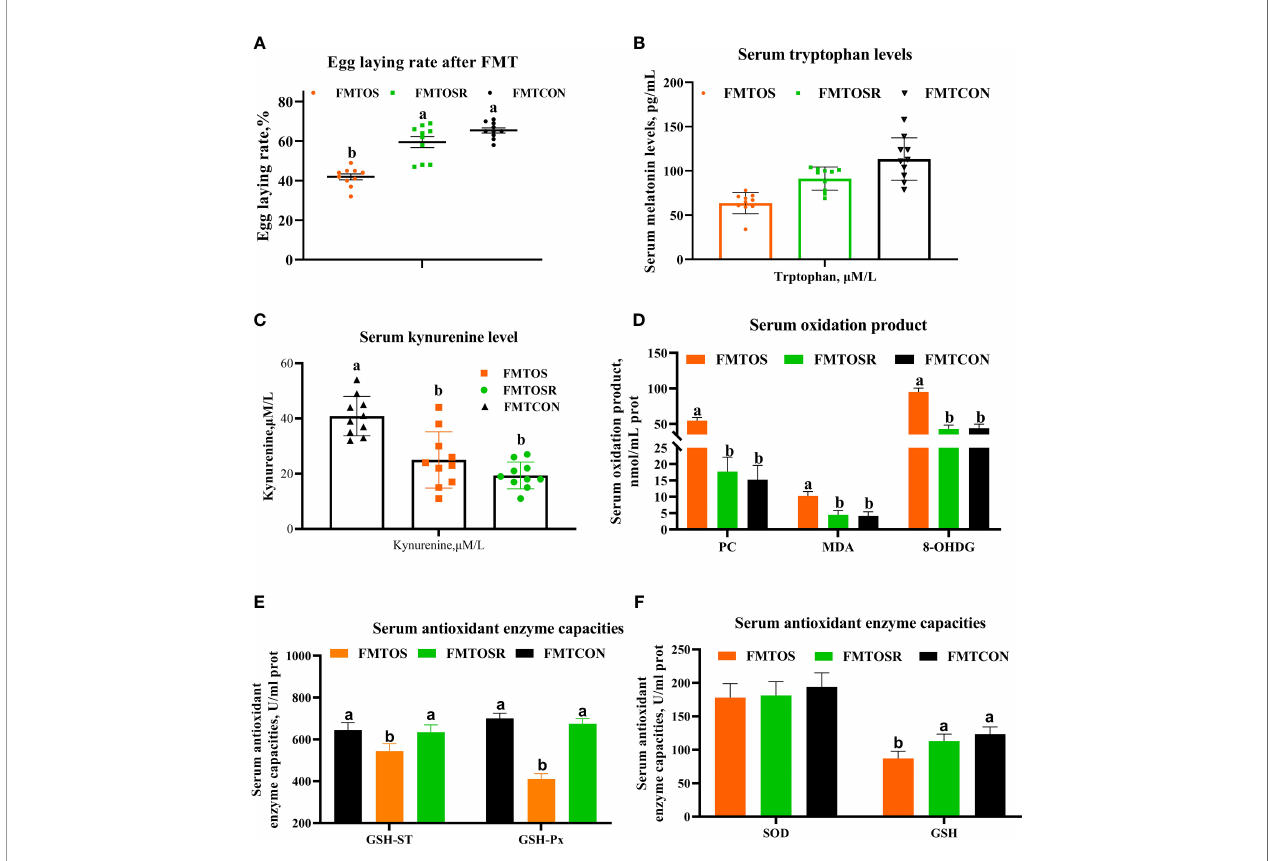
FIGURE 8 | Egg-laying rate, serum melatonin, and antioxidant enzyme activities were alleviated by fecal microbiota transplantation from a resveratrol supplementation diet (Exp.2). Data are means ± SEM represented by vertical bars or plot individual values ± SEM. (A) Egg-laying rate. (B,C) Serum tryptophan and kynurenine levels. (D-F) Serum antioxidant capacities. CON = control, OS = oxidative stress (injection of 800 m mol/kg BW of tBHP), OSR = CON + 600 mg/kg resveratrol; FMTCON, FMTOS and FMTOSR indicated the microbiota-depleted layers received microbiota transplantations from donor layer treated CON diet, tBHP, and OSR, individually; MDA = malondialdehyde, PC = protein carbonyl, T-AOC = total antioxidant capacity, SOD = superoxide dismutase, GSH = glutathione, GSH- ST = glutathione S — transferase, GSH-Px = glutathione peroxidase. Statistical signi fi cance was evaluated by the Turkey ’ s T-test, p <